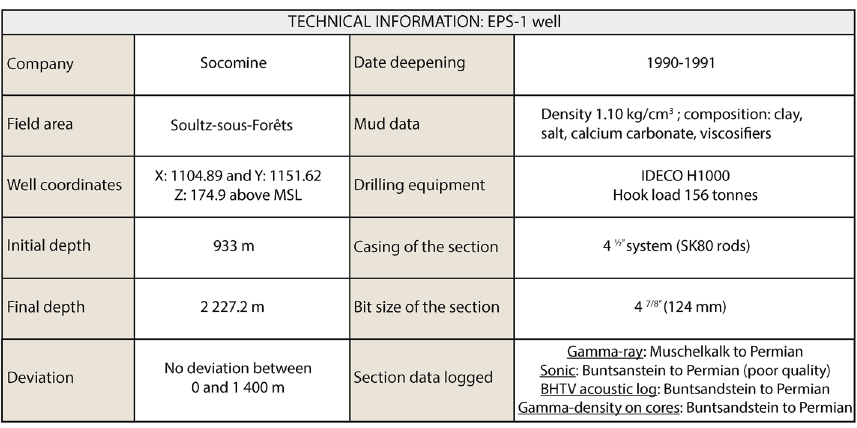
Table 1 Information about the EPS-1 exploration well, focusing on the Muschelkalk– Buntsandstein section (interest of the